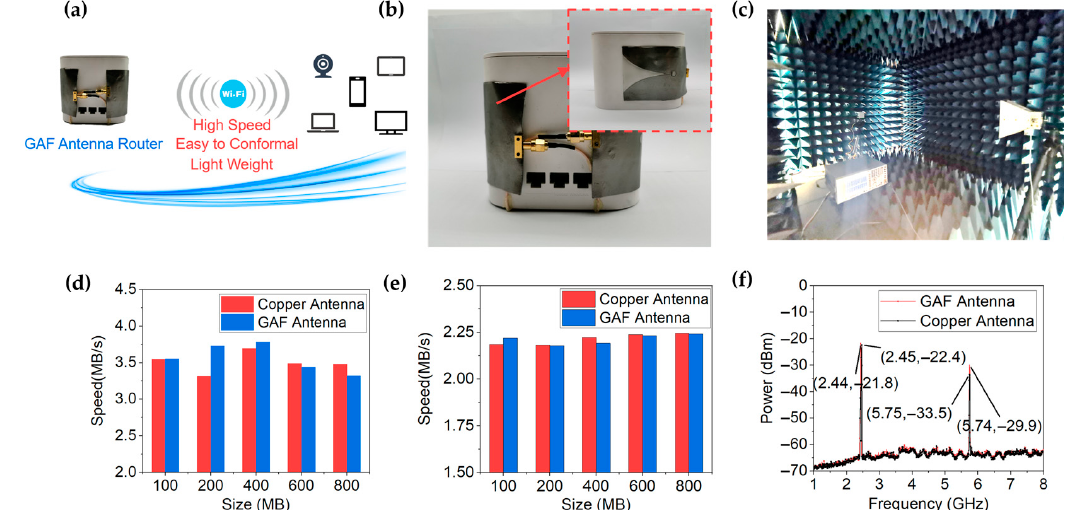
Figure 6. ( a ) Schematic diagram of application scenarios of GAF antenna router. ( b ) Digital photo of the fabricated GAF antenna conformed to a commercial router. ( c ) Photograph of the measurement environment. ( d ) Measured upload speeds of the routers with GAF antenna and copper antenna. ( e ) Measured download speeds of the routers with GAF antenna and copper antenna. ( f ) Measured spectrum power of the routers with GAF antenna and copper antenna.